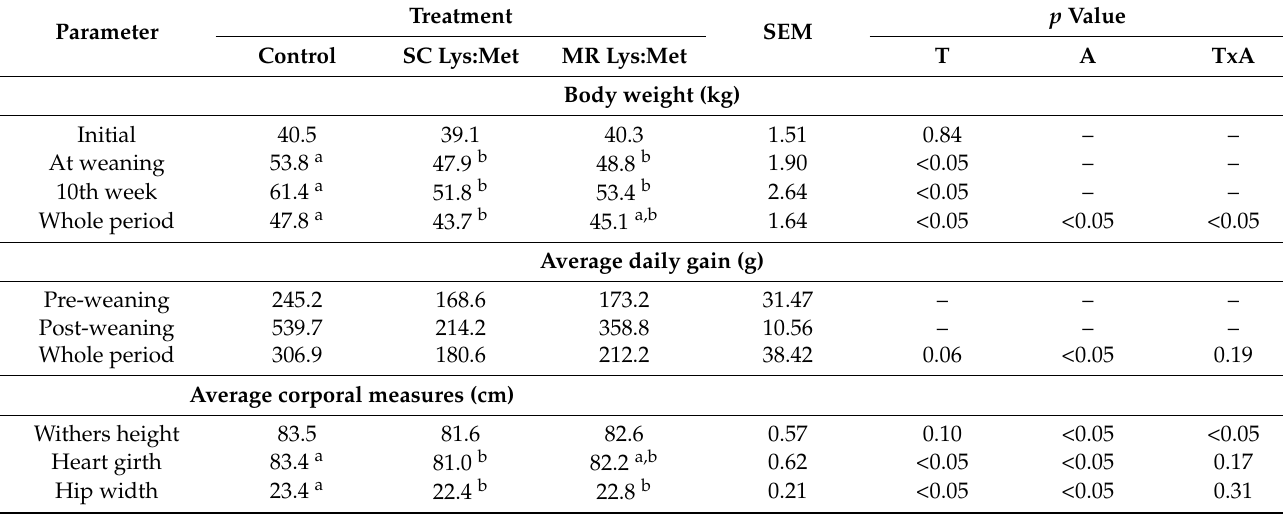
Table 3. Body weight, average daily gain and corporal measures of dairy calves with or without lysine and methionine supplementation in starter or milk replacer.